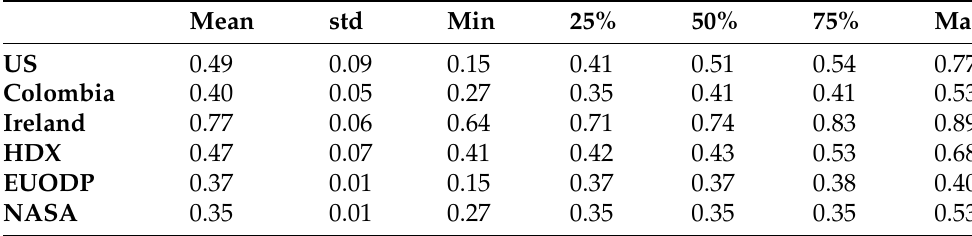
Figure 3. Overall metadata quality distributions. Table 4. Overall metadata quality descriptive